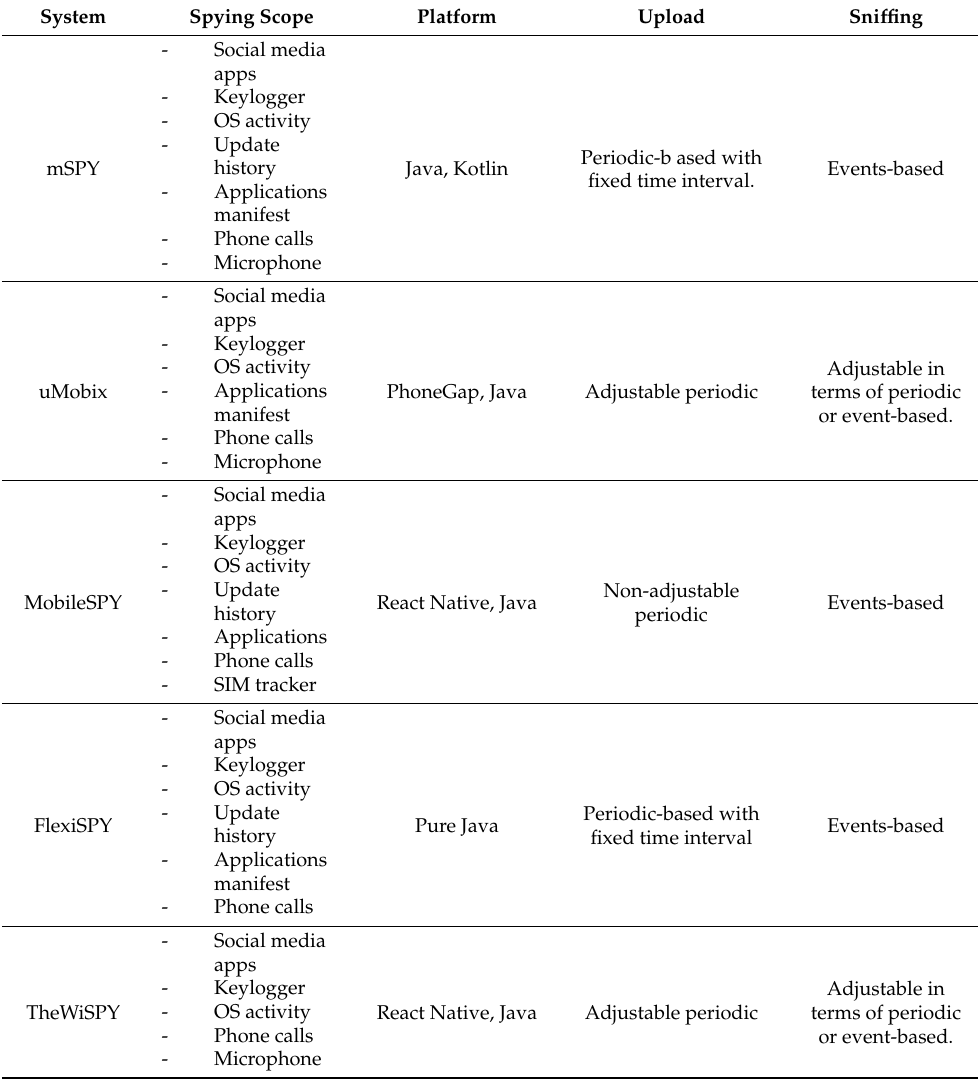
Table 4. High-level summary of the applications’